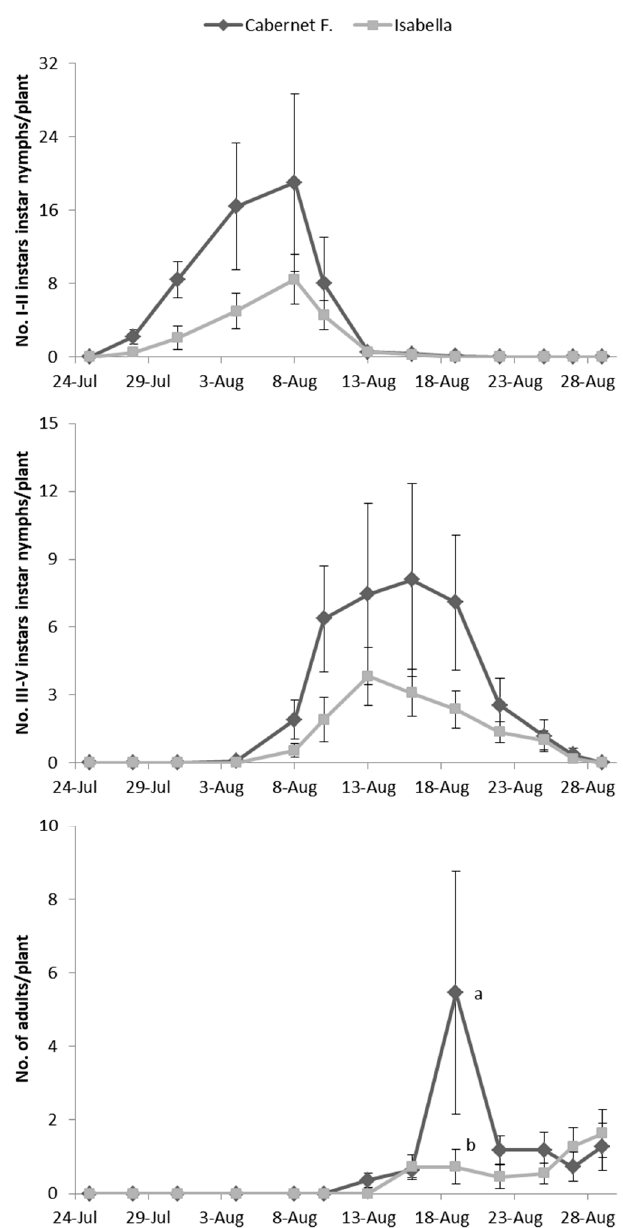
Figure 2. Abundance of Erasmoneura vulnerata nymphs and adults observed on caged potted vines (2008). Different letters indicate significant differences based on the Bonferroni test ( p = 0.05).